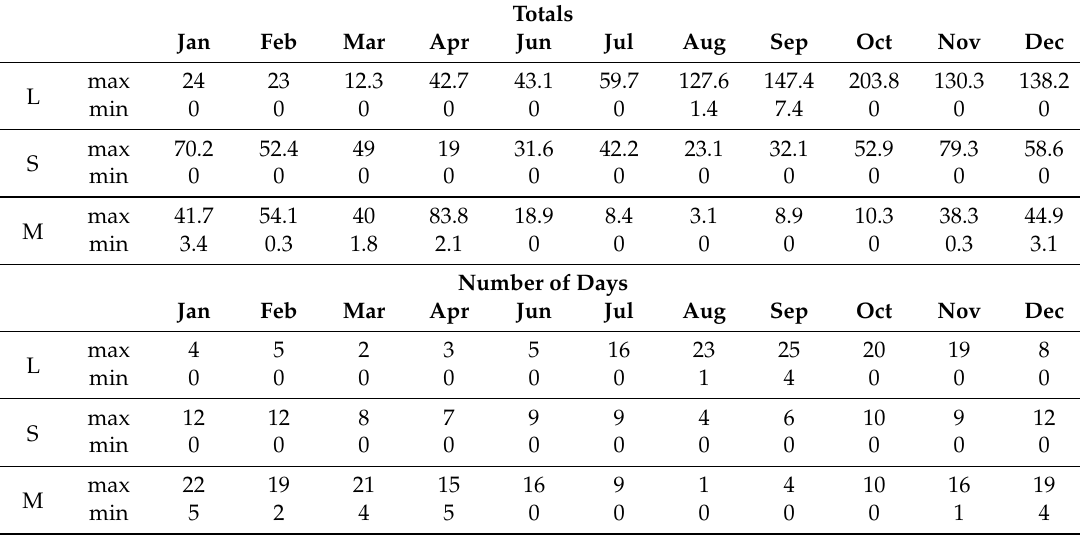
Table 1. Extreme values of monthly totals and number of days with liquid, mixed, and solid precipitation in the 1979–2017